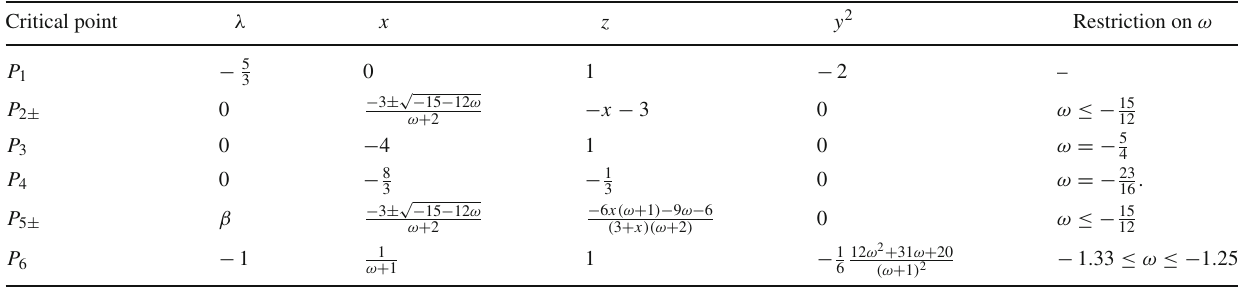
Table 1 Critical points of the system given by Eqs. (14)–(15) with ˙ H = 0. As explained in the text, only P 2 ± , P 5 ± , and P 6 will be considered in the subsequent analysis. The parameter β is given by β = 1 Γ − 1 Critical point λ x z y 2 Restriction on